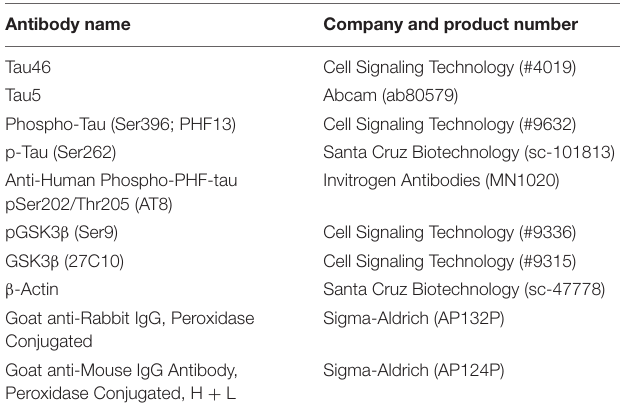
TABLE 1 | Antibodies used for